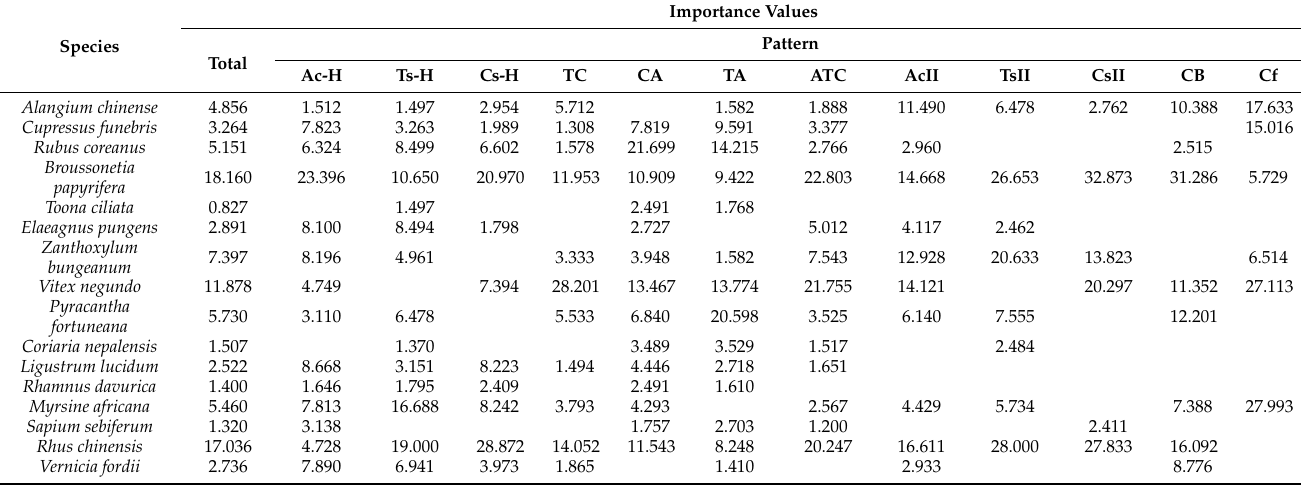
Table 3. The importance values of dominant shrub populations under different reconstruction